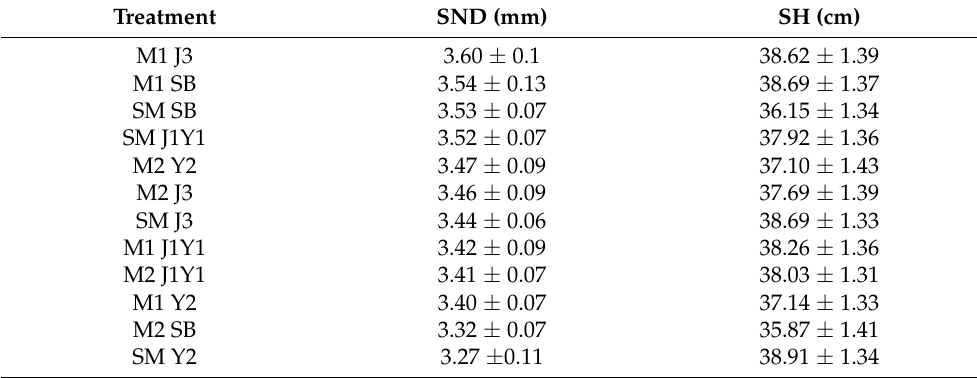
Table 3. Mean and standard error of Stem neck diameter (SND) and Stem height (SH) of Prosopis alba seedlings Interaction are combination of inoculation (SM: Non inoculated, M1: Claroideoglomus claroideum , Claroideoglomus etunicatum ; Diversispora spurca , Funneliformis mosseae , and Rhizophagus intraradices ; M2: Claroideoglomus claroideum , Claroideoglomus etunicatum , Funneliformis constrictum , Funneliformis mosseae , and Rhizophagus clarus ) and biostimulant foliar applications (SB: Seedlings sprayed with only water, J3: seedlings sprayed with Larrea divaricate (3% w / v ), Y2: seedlings sprayed with Ilex paraguariensis (2% w / v ), and J1Y1: mixture of both biostimulants (1% w / v : 1% w / v